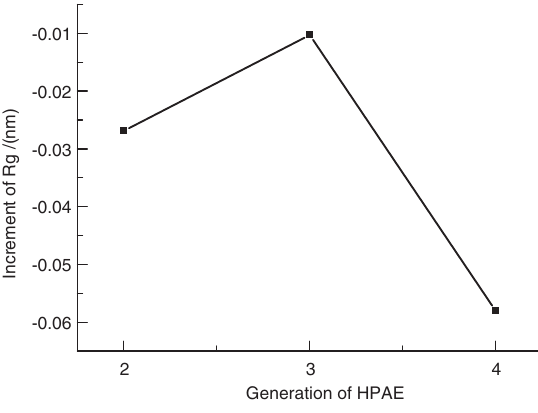
Figure 7 Relationship between ≥ Rg and